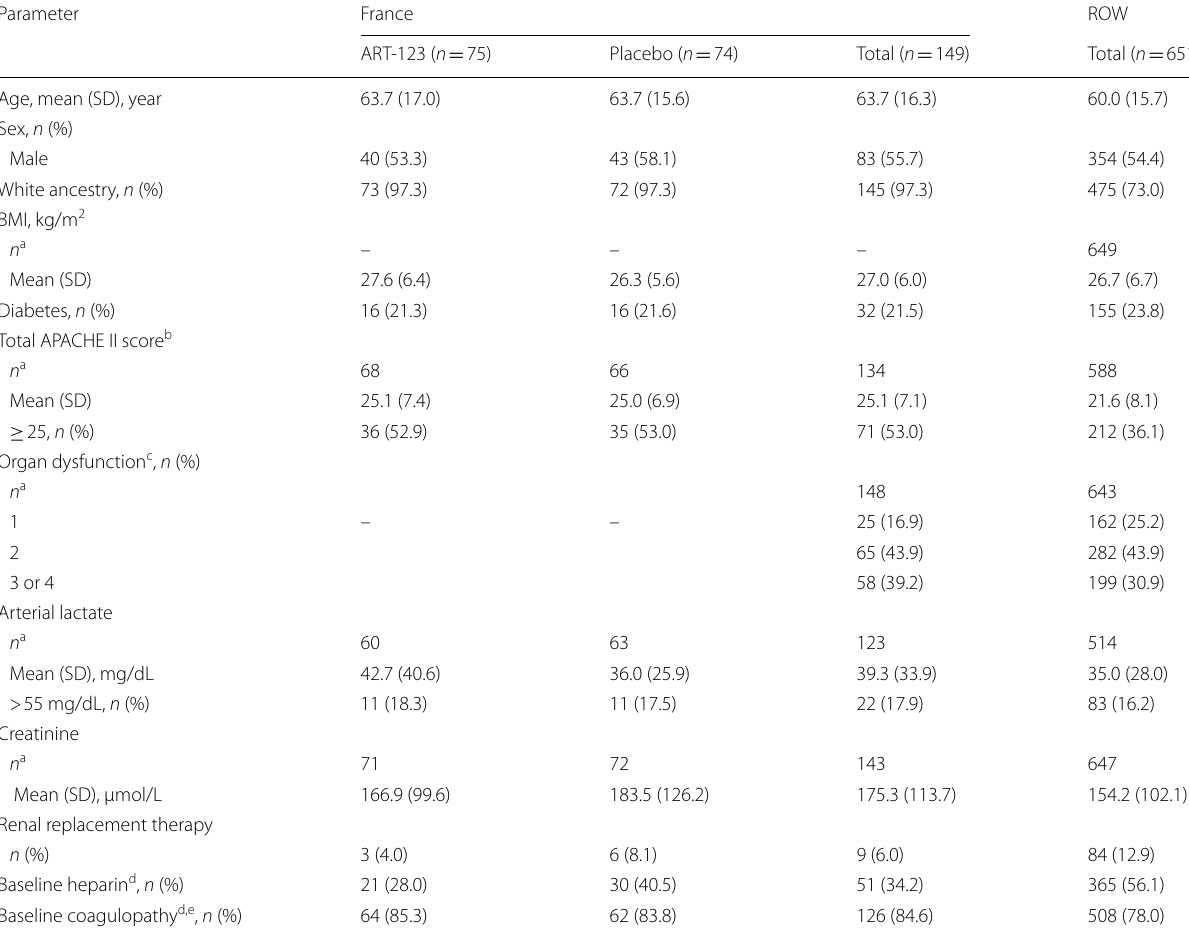
Table 1 Demographic and baseline characteristics of patients with SAC in France and